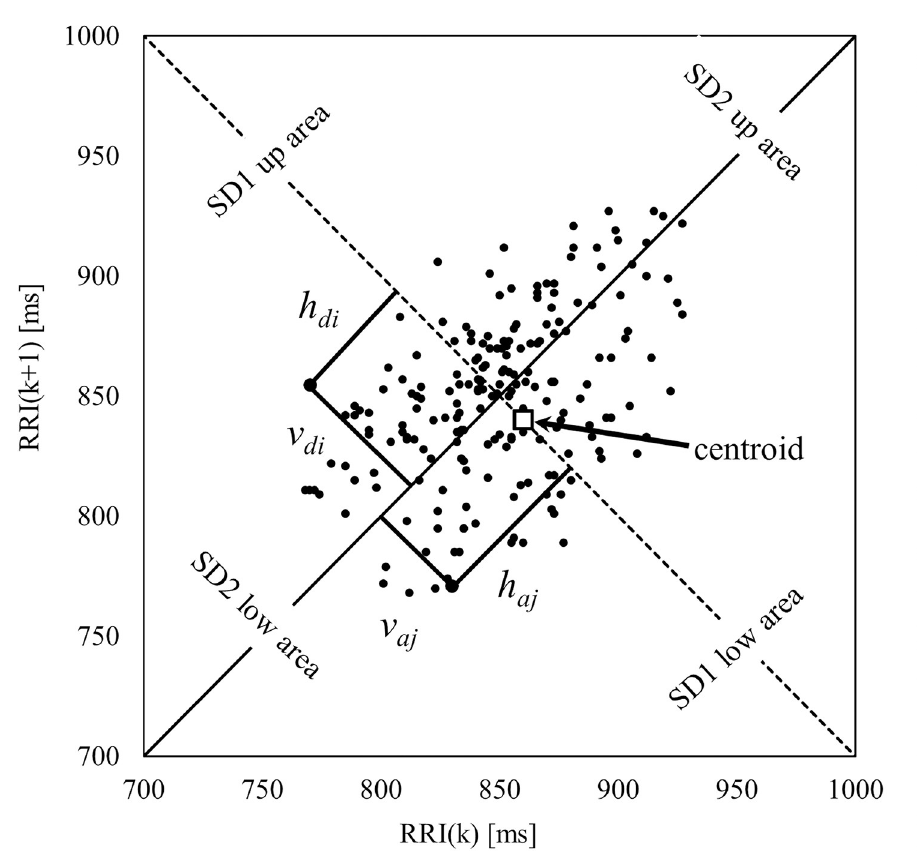
Fig 3. Poincare´ plot. The Poincare´ plot is defined by the lengths of the short side (SD1) and long side (SD2) of an ellipse drawn by RRI (k) and RRI (k+1) . In the RRI, SD1 is an index showing rapid change, while SD2 shows subtle change. adjusted coefficient of determination (adjusted R-squared), which included both the SD2 indexes and BMI, was 0.466. A recalculation of the multiple regression analysis was under- taken as the contribution of BMI was not high. As a result, the adjusted R-squares of the esti- mation model that had only included the SD2 indexes was only slightly lower, at 0.460 (p < .001). As shown in Table 3, the results suggest that the amount of change in core body temper- ature Δ Temp(i) may be predicted sufficiently well by the functions SD2(i), SD2(i-1), and Δ Temp(i-1). Eqs (6) and (7), where the symbol Δ denotes the amount of change and ^ the esti- mated value.